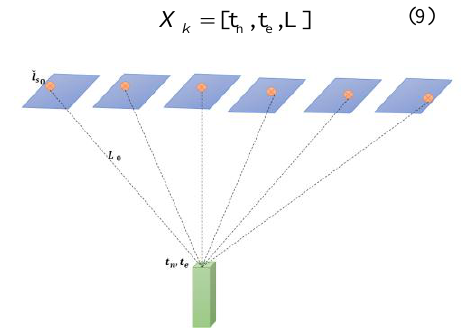
Figure 2: Point location in sequence of